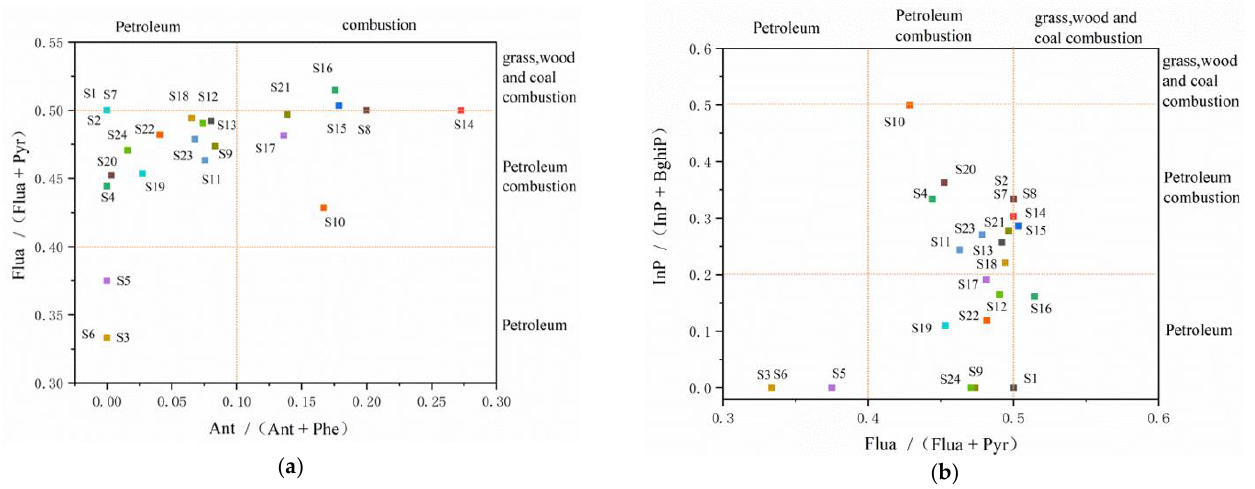
Figure 5. Plots of diagnostic ratios: ( a ) Flua / (Flua + Pyr) versus Ant / (Ant + Phe); ( b ) InP / (InP + BghiP) versus Flua / (Flua + Pyr) in sediments from the lake bay and adjoining river.